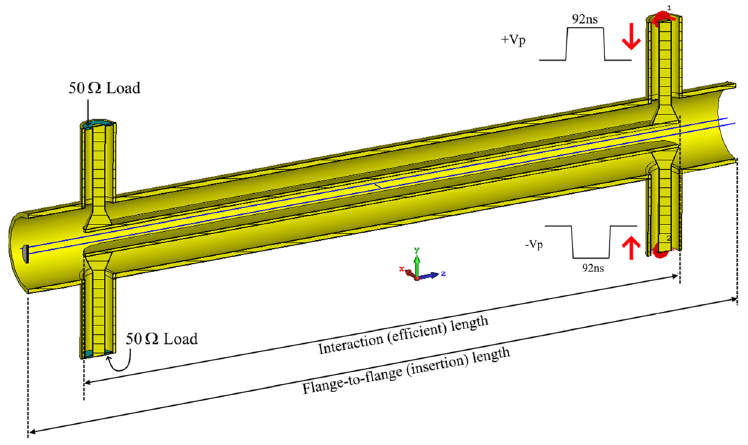
Figure 2. Conceptual design of the stripline traveling wave kicker as a beamline insertion device.